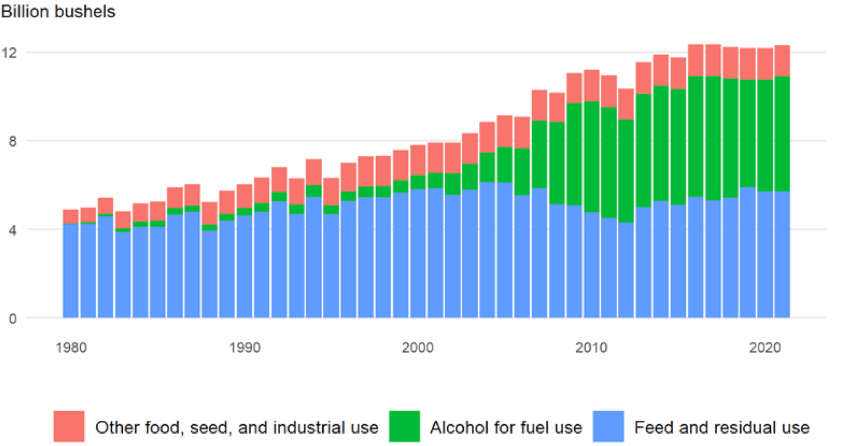
Figure 1. Non-food uses of corn starch derived from wet-milling process.